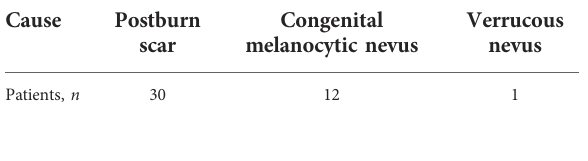
TABLE 1 The cause of the patients in our